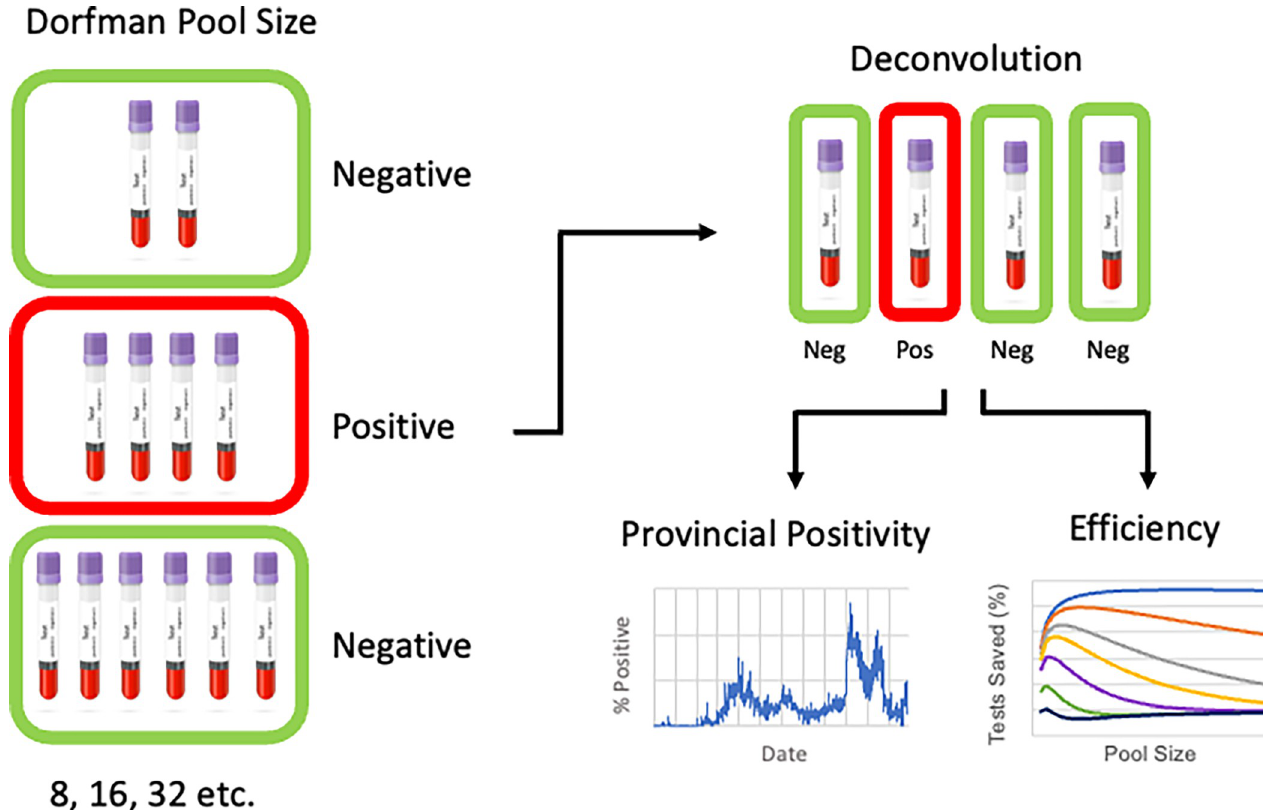
Fig 2. Dorfman pooling schematic. Samples are represented by tubes, and PCR tests are represented by green (negative) or red (positive) rounded rectangles. When a Dorfman pool is positive, deconvolution is required. When a positive pool is detected each sample is individually re-tested. Pool sizes of 4, for example would result in 7 total tests utilized for analysis of 12 samples. In addition, positivity rate, sensitivity, and efficiency gained need to be taken into consideration when choosing an appropriate pool size for large scale testing. https://doi.org/10.1371/journal.pgph.0001793.g002 Statistical Analysis- Paired Wilcoxon T-tests were used to determine the change in Ct value in pooled specimens at each pool size compared to their unpooled Ct values. Sensitiv- ity and 95% confidence intervals for each pool size were calculated by the exact Clopper- Pearson method in comparison to individual specimen testing. Efficiency data was calcu- lated using the calculation Tests Saved ¼ ð 1 (cid:0) p Þ k (cid:0) 1 , where p is positivity rate, and k is k pool size [13]. This was used to determine optimal Dorfman pooling sizes adapted based on positivity rate. Data from this was plotted to define test efficiency curves for Dorfman pooled protocols. Optimally pooled Dorfman testing sizes based on positivity rate were Table 1. Test sensitivity based on Dorfman pooling size. True positive and false negative tests are determined against gold standard of individual testing. Dorfman Pool